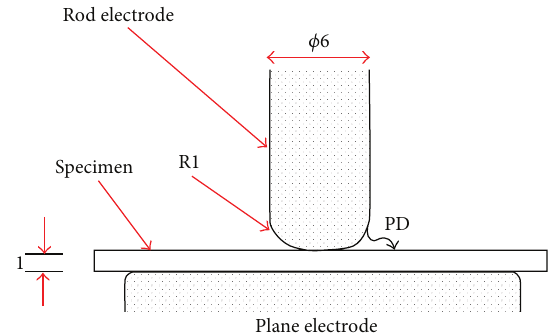
Figure 10: IEC (b) electrode configuration system consisting of a rod and a plane stainless-steel electrode [27].